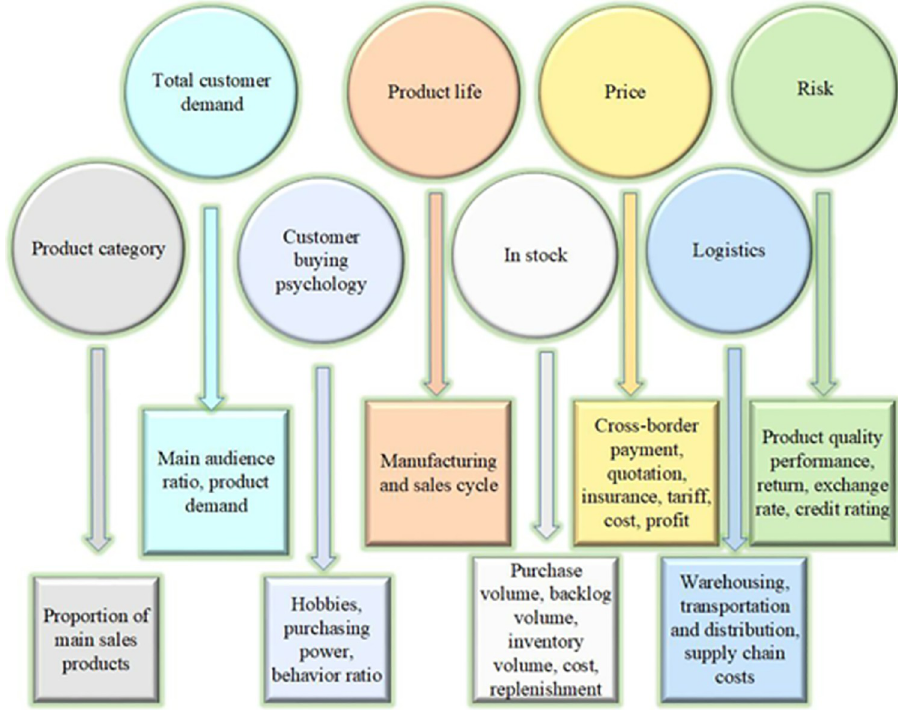
Fig 7. Analysis of experimental data of factor